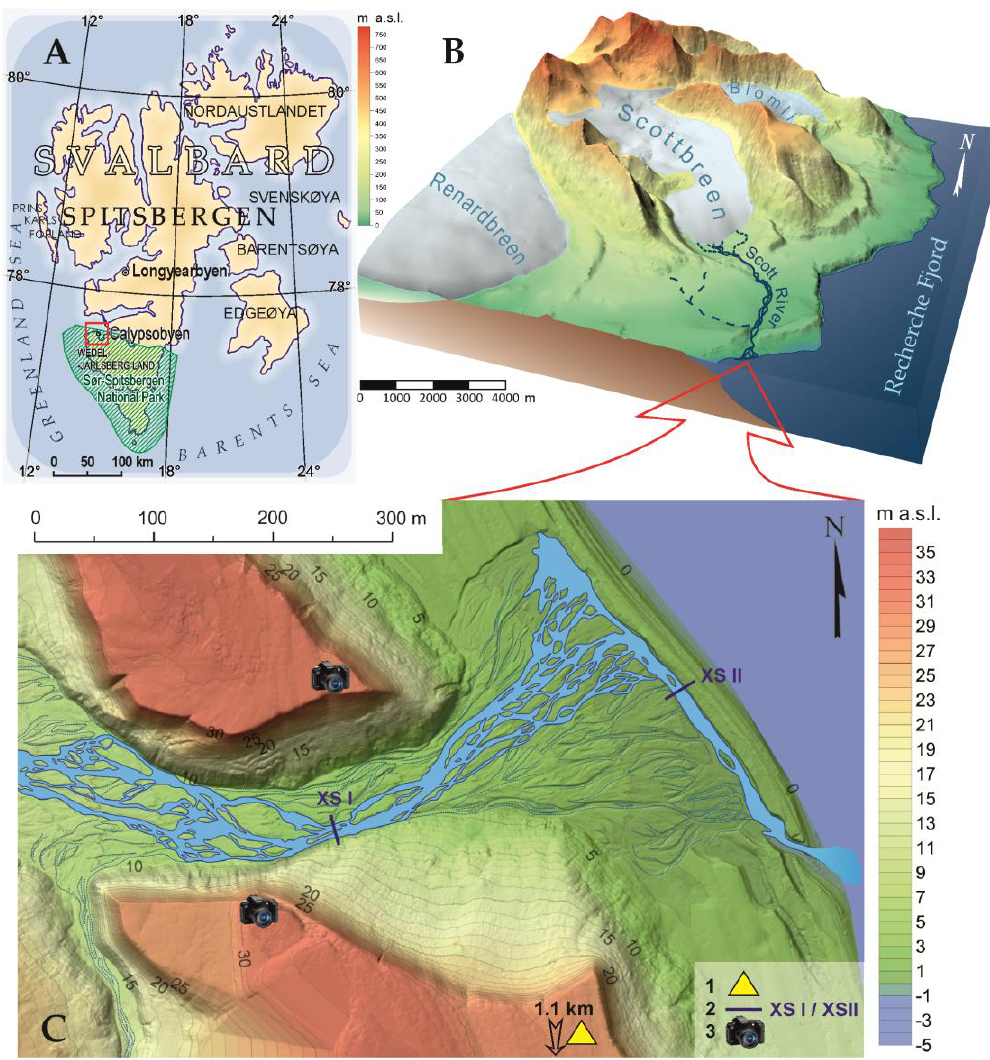
Figure 1. ( A ) Location of the study area on the northwestern part of Wedel Jarlsberg Land (SW Sval- bard); Sør-Spitsbergen National Park marked by green simple hatch pattern. ( B ) Three-dimensional model of the Scott River catchment area. ( C ) An alluvial fan in the lower section of the Scott River valley: 1. location of meteorological station; 2. hydrometric gauges; 3. photography sites; the blue dotted lines depict the distribution channels (drains only during floods).